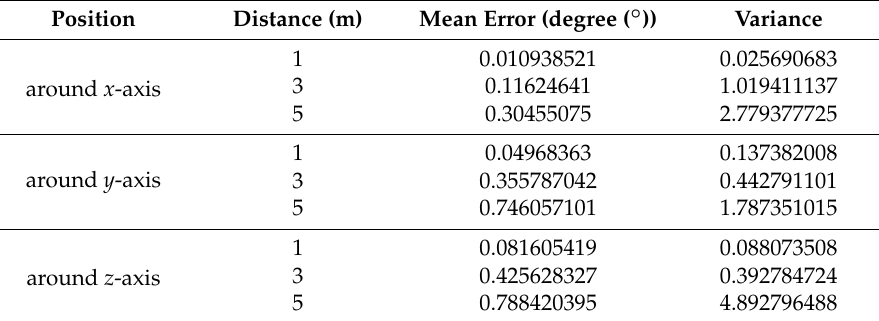
Table 2. The performance of rotation matrix.